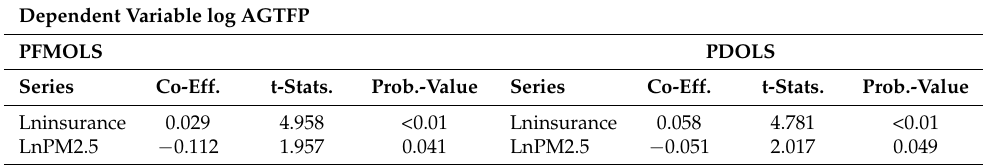
Table 6. Results of the PFMOLS and the PDOLS